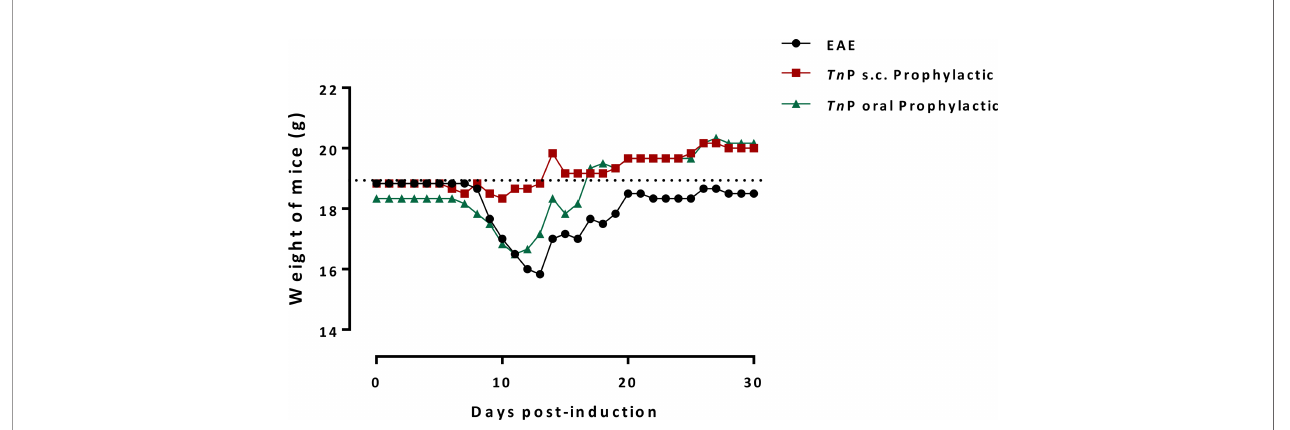
FIGURE 7 | Subcutaneous or oral treatments with Tn P prevent weight loss at the effector phase and increase in the chronic phase of the disease. BL6 mice (n = 5/ group) immunized with (MOG) peptide in incomplete Freund ’ s adjuvant added with M . tuberculosis were injected 2 times with Pertussis toxin after immunization. Mice were s.c. or orally treated with Tn P at 3 mg/Kg every other day starting at the day of immunization in the prophylactic regimen (day 0 to 9). The EAE controls were injected with 0.9% saline alone (Vehicle). Treated-mice weighed daily were compared to normal weight of vehicle-treated or healthy mice (dotted